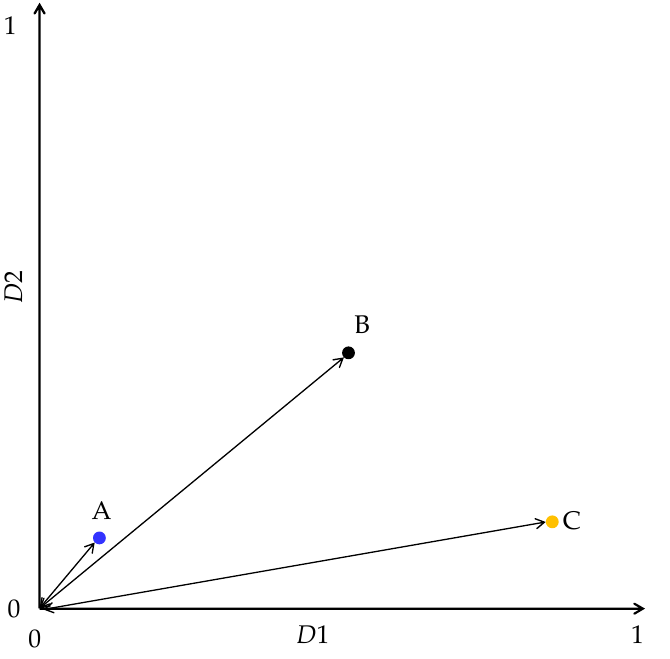
Figure 14. Relative positions of the arbitrary alternatives on the D 2 versus D 1 plot.